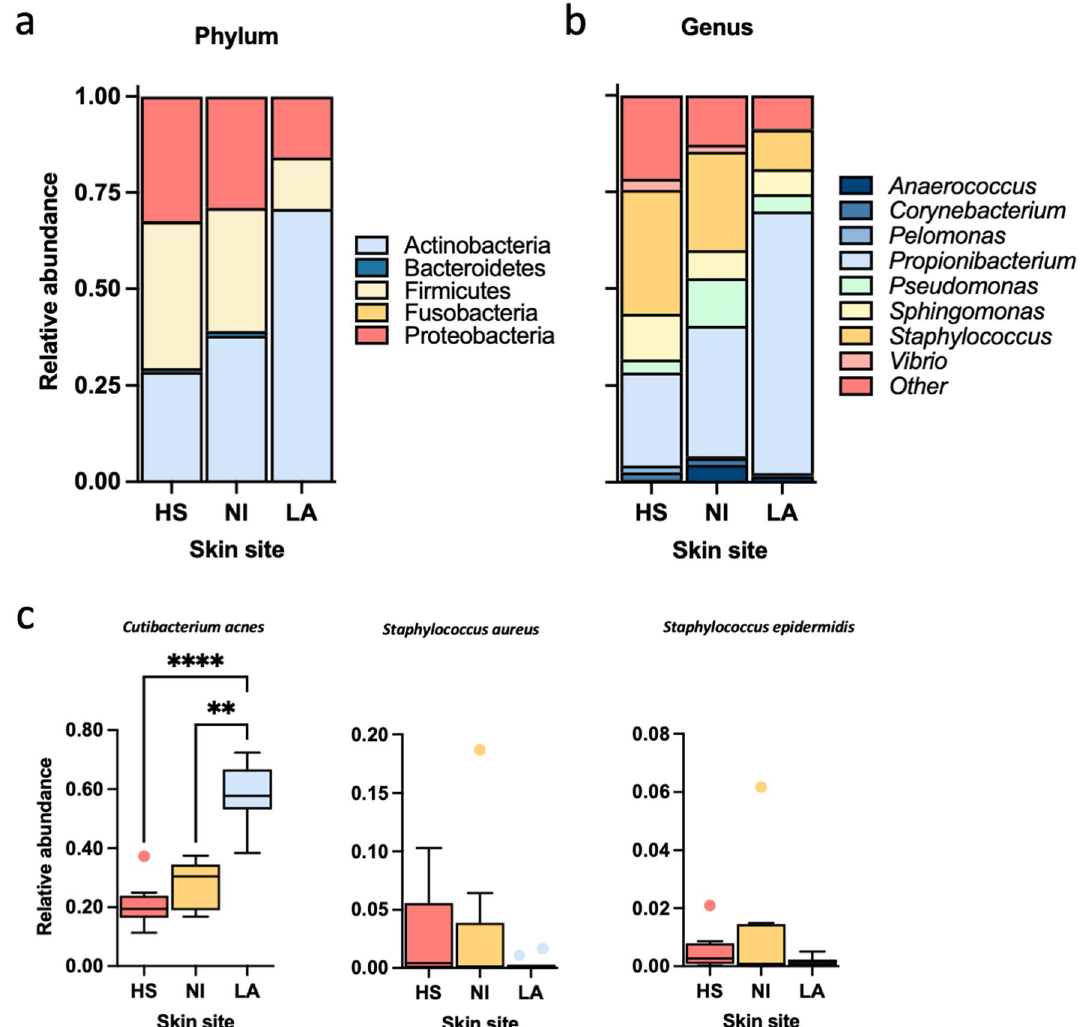
Figure 2. Microbiota variation between healthy subjects and acne patients. Skin microbiota was evaluated on samples collected from the skin of ten healthy subjects (HS) and non-inflammatory (NI) and inflammatory lesions (AL) of 10 acne patients. Relative abundances at the phylum level ( a ) and top eight genera ( b ) were represented in a stacked bar plot. ( c ). Relative abundance was evaluated at the species level for